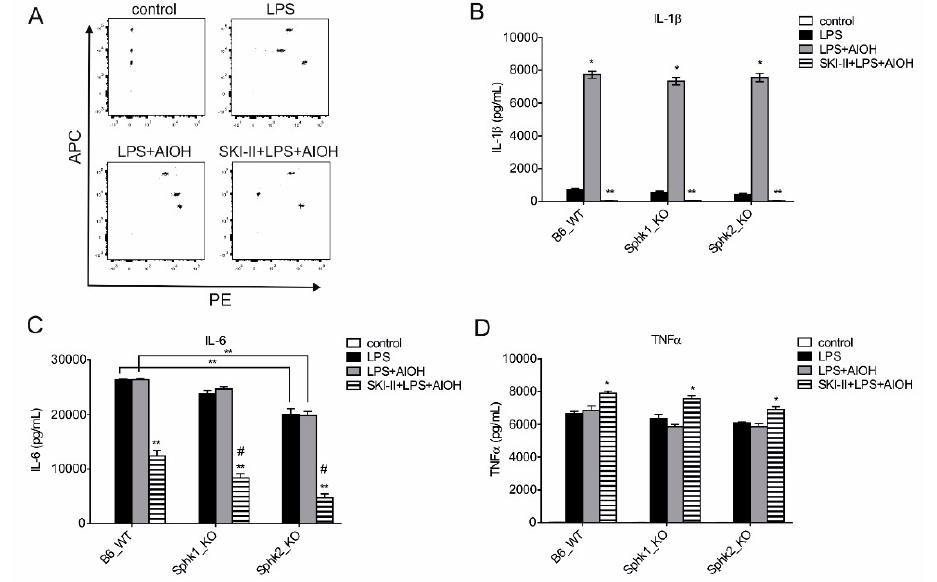
Figure 5. Individual SPHKs are redundant in NLRP3 inflammasome activation. Bone marrow-derived macrophages (BMDMs) from B6 WT, Sphk1 KO, and Sphk2 KO were stimulated with LPS alone or in combination with 10 µ M SKI-II, 10 µ g / mL IMQ, and 100 µ g / mL AlOH for 24 h. Cell-free supernatants were harvested and analyzed by CBA. ( A ) Representative FACS dot-plot of phycoerythrin (PE) and allophycocyanine (APC), ( B ) IL-1 β , ( C ) IL-6 and ( D ) TNF- α level. Data are means ± SEM, n ≥ 4 mice. # , significant to B6 WT; * p < 0.05; ** p < 0.001; p values were calculated using two-way ANOVA with Sidak correction.